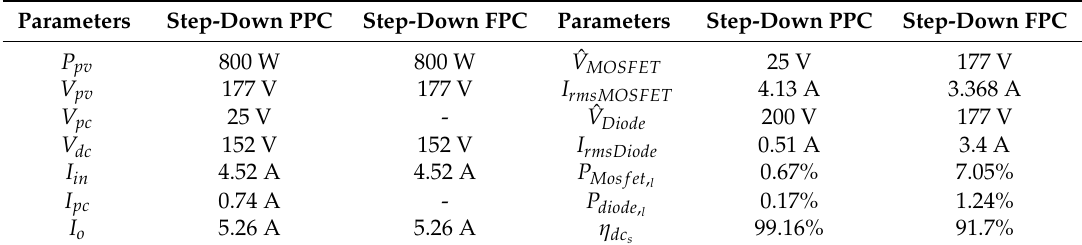
Table 3. Simulation results for a step-down PPC and an isolated H-bridge